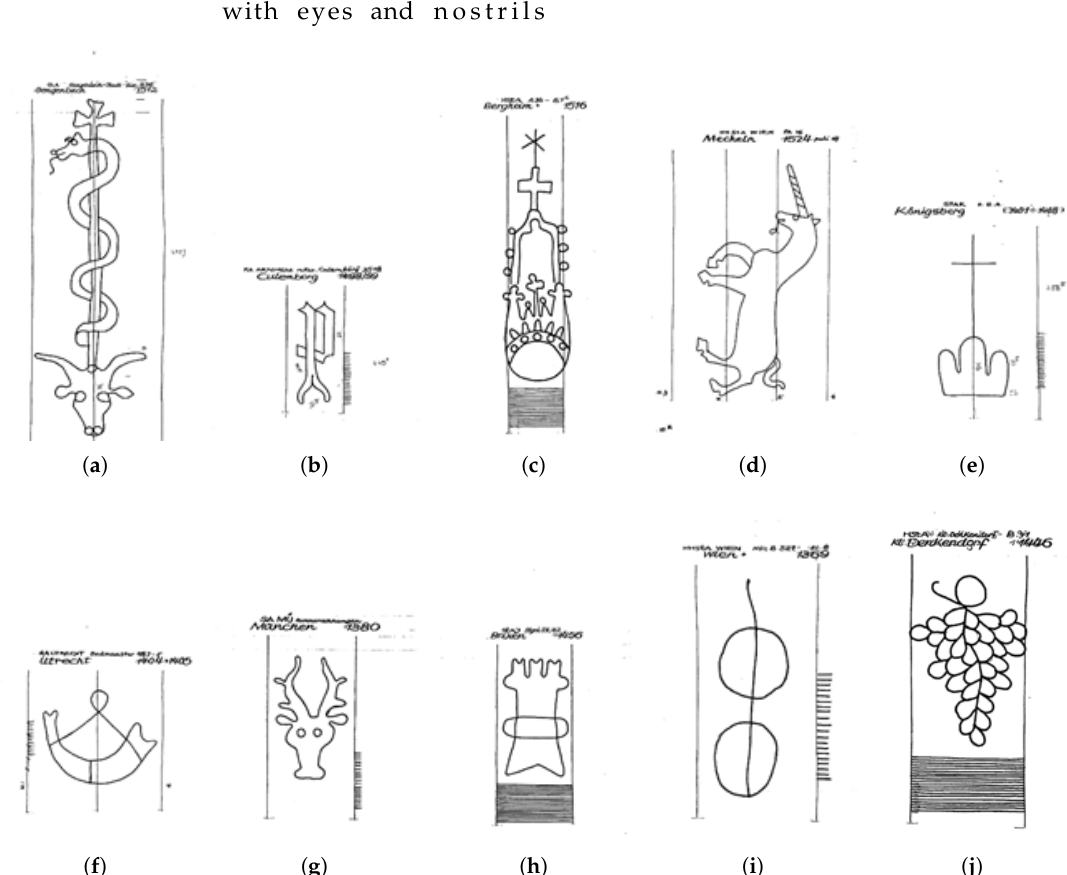
Figure 3. Representation of the class motifs for all 10 classes of TestSet1000. A motif class contains watermarks with similar motifs, but their shape and/or size can vary considerably. Thus, sacrificing precision in the definition for the sake of intuition, one can interpret it as the average class